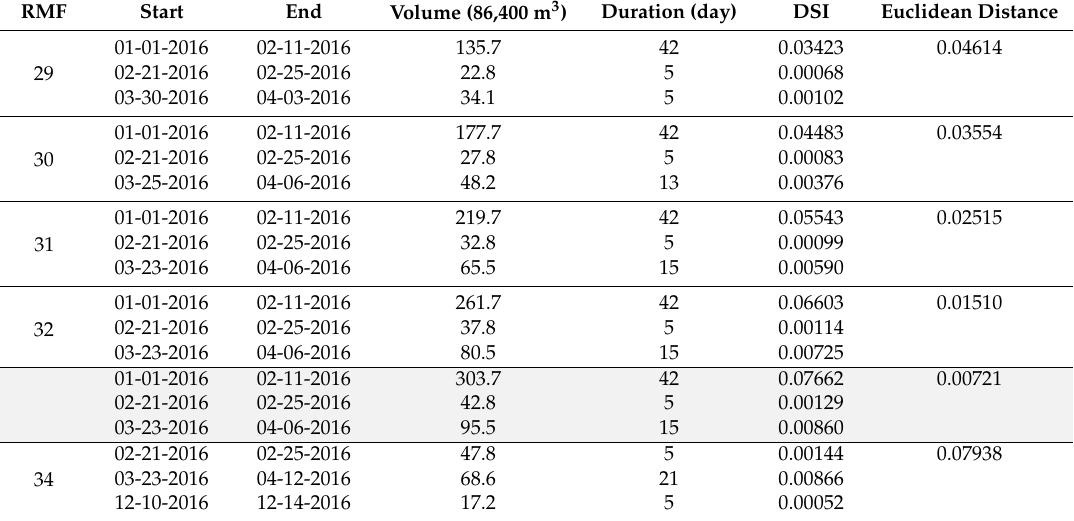
Streamflow deficit events and their severity indexes for Gyuam (2012–2016, non-irrigation period).